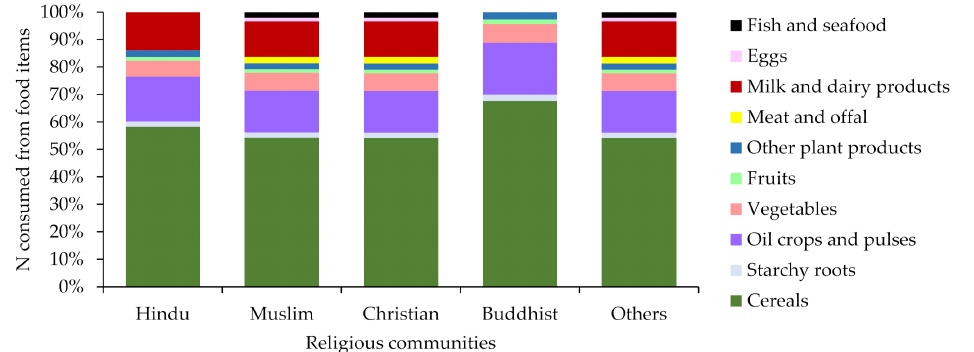
Figure 2. Nitrogen consumed from food by religion in India in 2013.